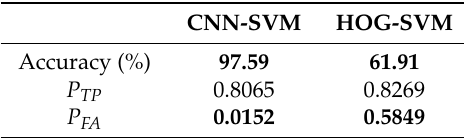
Table 12. Comparison of HOG and CNN feature extraction methods for the first